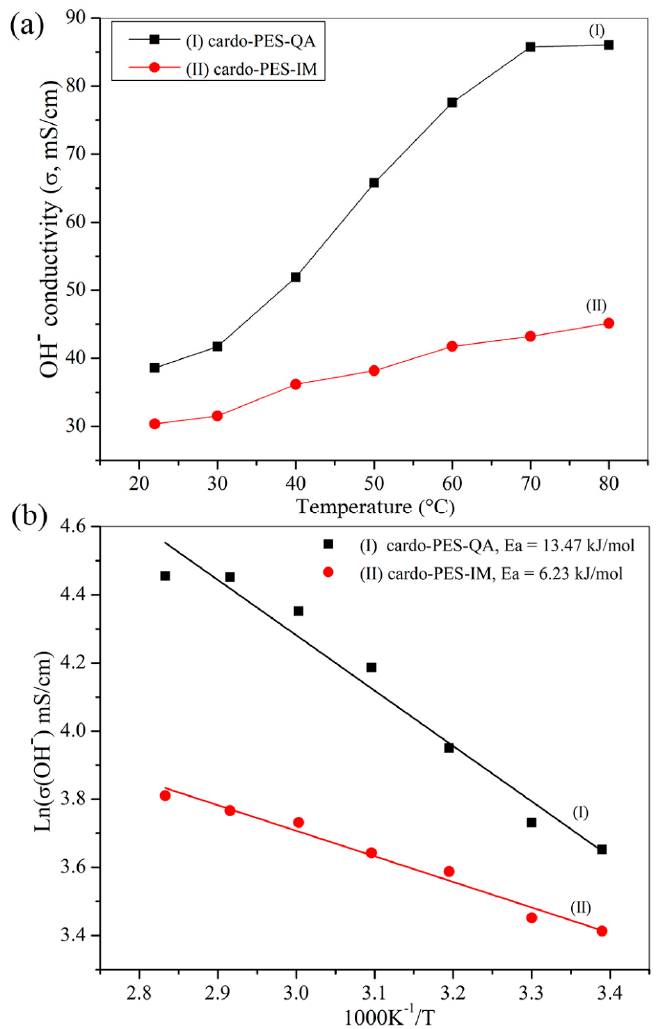
Figure 9. ( a ) The OH - conductivity as a function of temperature and ( b ) Arrhenius temperature dependence of OH - conductivity ( σ ) of the AEMs. At higher temperature, the higher local mobility of water with certain perturbation in chain structures creates long-range ion rich percolated structures that facilitated ion transportation in the membrane resulting in higher ion conductivity. The AEMs exhibited hydroxide conductivities of 30–38 mS/cm at 20 °C (and 45–86 mS/cm at 80 °C). The lower ion conductivity of cardo-PES-IM than cardo-PES-QA is due to the lower IEC, lower water uptake, and lower basicity of imidazolium groups [33]. The conductivity values were com- parable or higher than the previously reported AEMs at similar IEC [14,23,26–31,34–45].